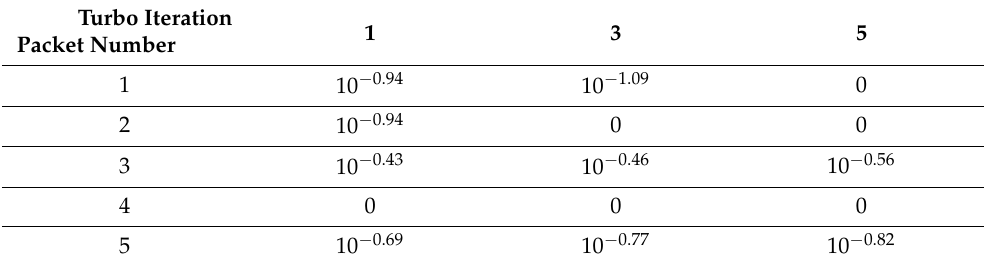
Table 4. Performance analysis according to the number of Turbo iterations. ( N c = 32, N b = 4). Turbo